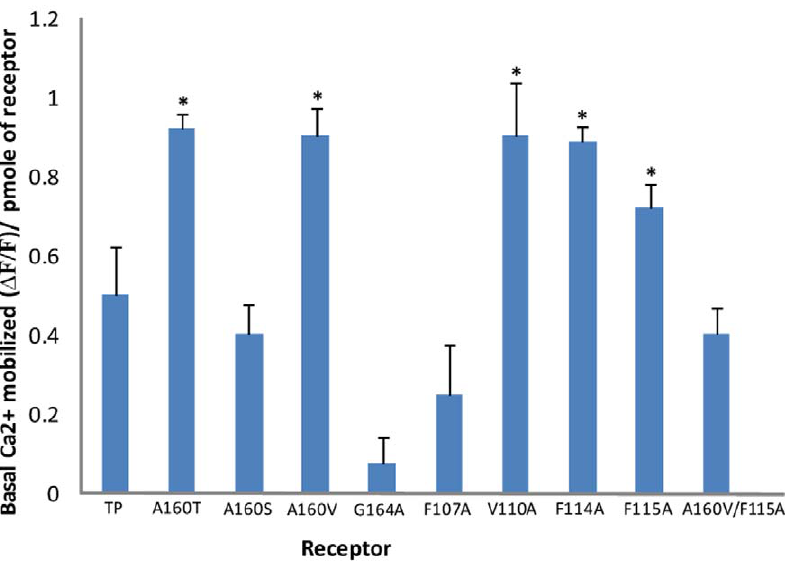
Figure 5. Characterization of basal or agonist-independent activity. Bar plot representation of the basal amount of calcium released by TP and mutants per picomole of functional protein expressed (see methods). The G164V mutant could not be assessed as it did not bind to the antagonist, and the amount of functional receptor could not be calculated. Results are obtained from a minimum of two independent experiments done in duplicate. The single astrix indicate there is a significant difference in the amount of calcium released at zero concentration of agonist with respect to wild type TP at significance level p , 0.05. Error bars indicate mean 6 SD.